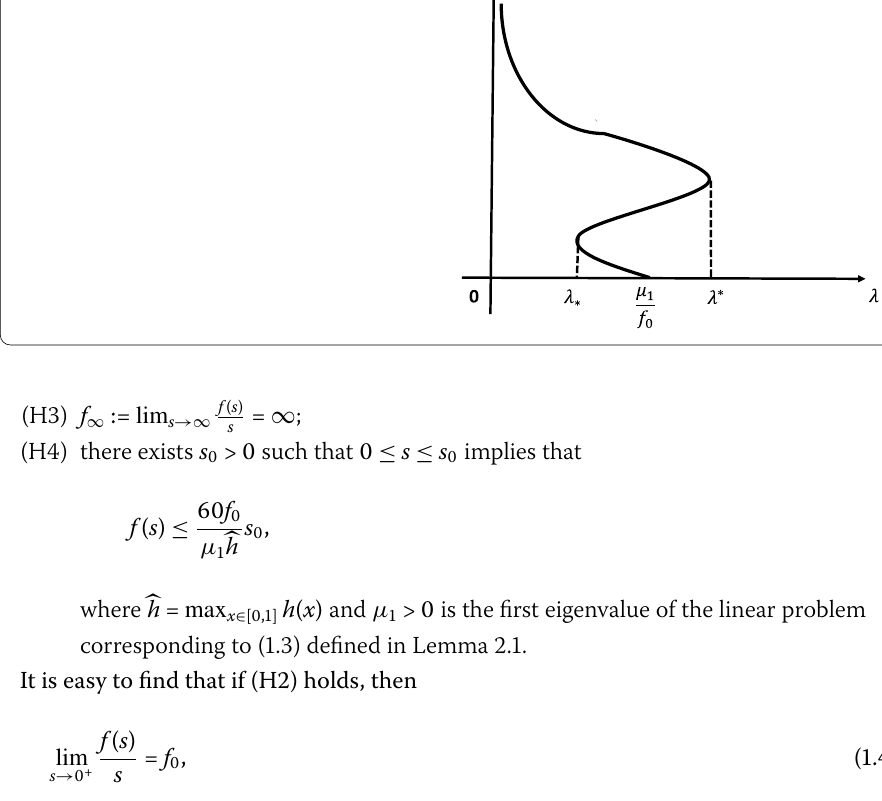
Figure 2 Reversed S -shaped connected of positive solutions set of